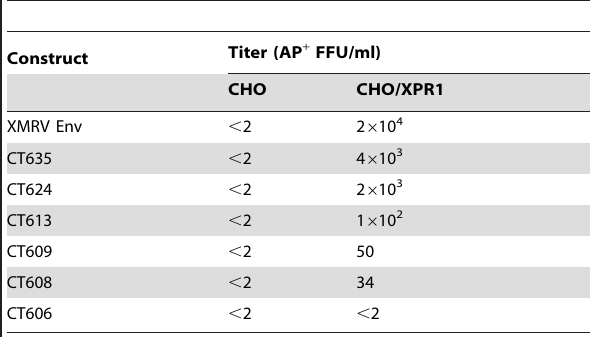
Table 1. Titers of XMRV Env pseudovirions in CHO and CHO/ XPR1 cells.